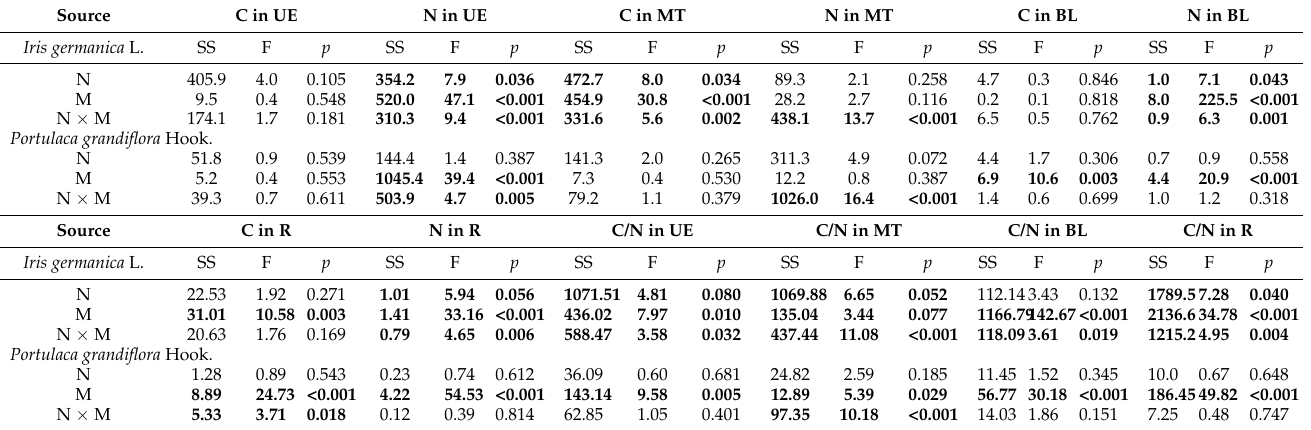
Table 2. The effects of nitrogen-containing PM 2.5 addition concentration (N), sampling date (M), and their interaction (N × M) on the weight percentage of carbon (C), nitrogen (N), and C/N in the upper epidermis (UE), mesophyll tissue (MT), bulk of leaves (BL), and roots (R) in Iris germanica L. and Portulaca grandiflora Hook. The linear mixed-effects model used the Kenward–Roger method as a denominator of degrees of freedom.